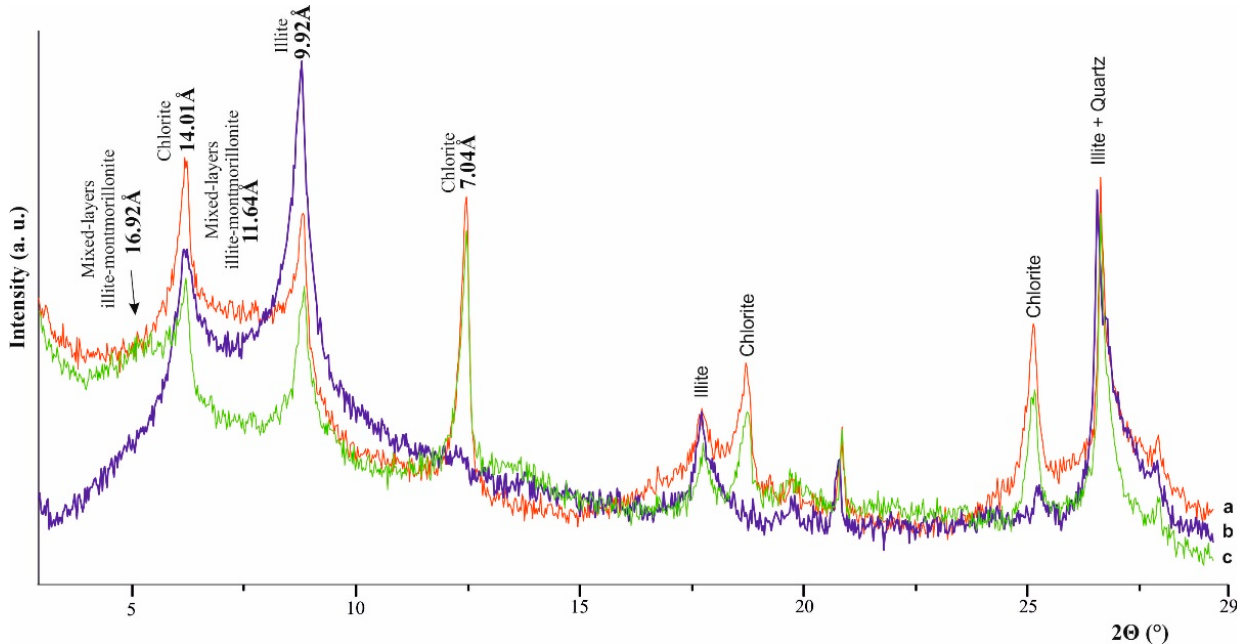
Figure 3. Diffractogram of the sample 5.1.20–30 clay component. Red indicates the initial diffractogram ( a ), blue—after calcination at 550 °C ( b ), green—after saturation of the sample with ethylene glycol ( c ).